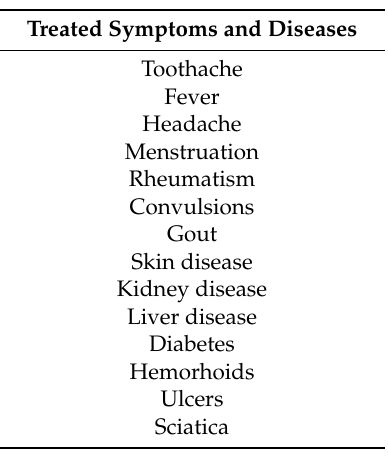
Table 1. Main traditional uses of Capparis spinosa ( C. spinosa ) to ease symptoms and treat